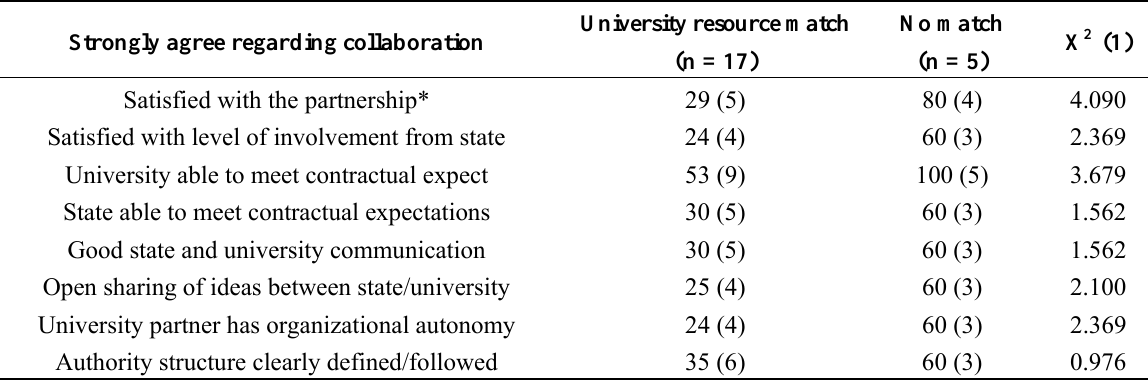
Table 4. Prevalence (%) of agencies reporting strong agreement to collaboration items by matching dollar requirement ( N = 22).